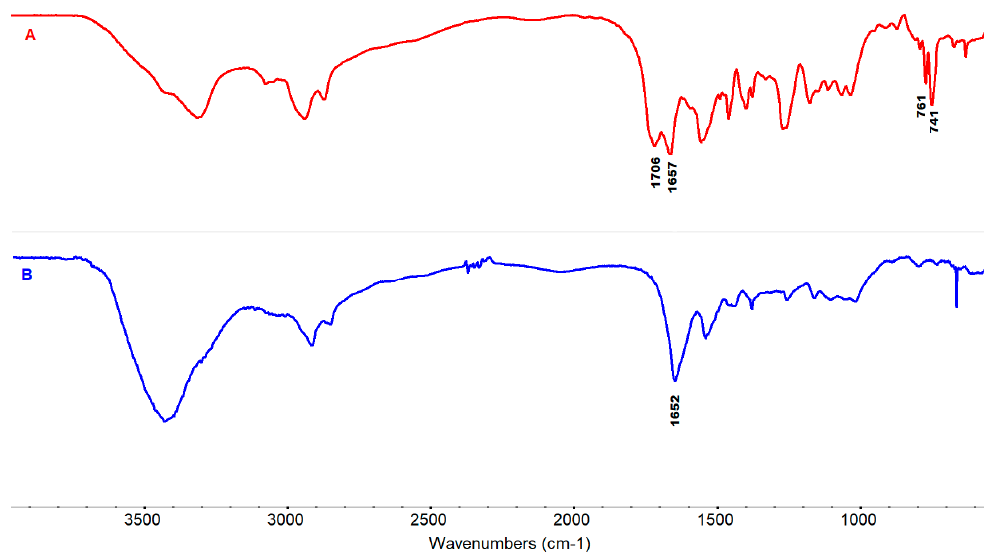
Figure 4. FT-IR spectra of: ( A ) the protected Poly( N ε -Fmoc- l -Lysine) 25 ; and, ( B ) the deprotected Poly( l -Lysine) 25 homopolymer.